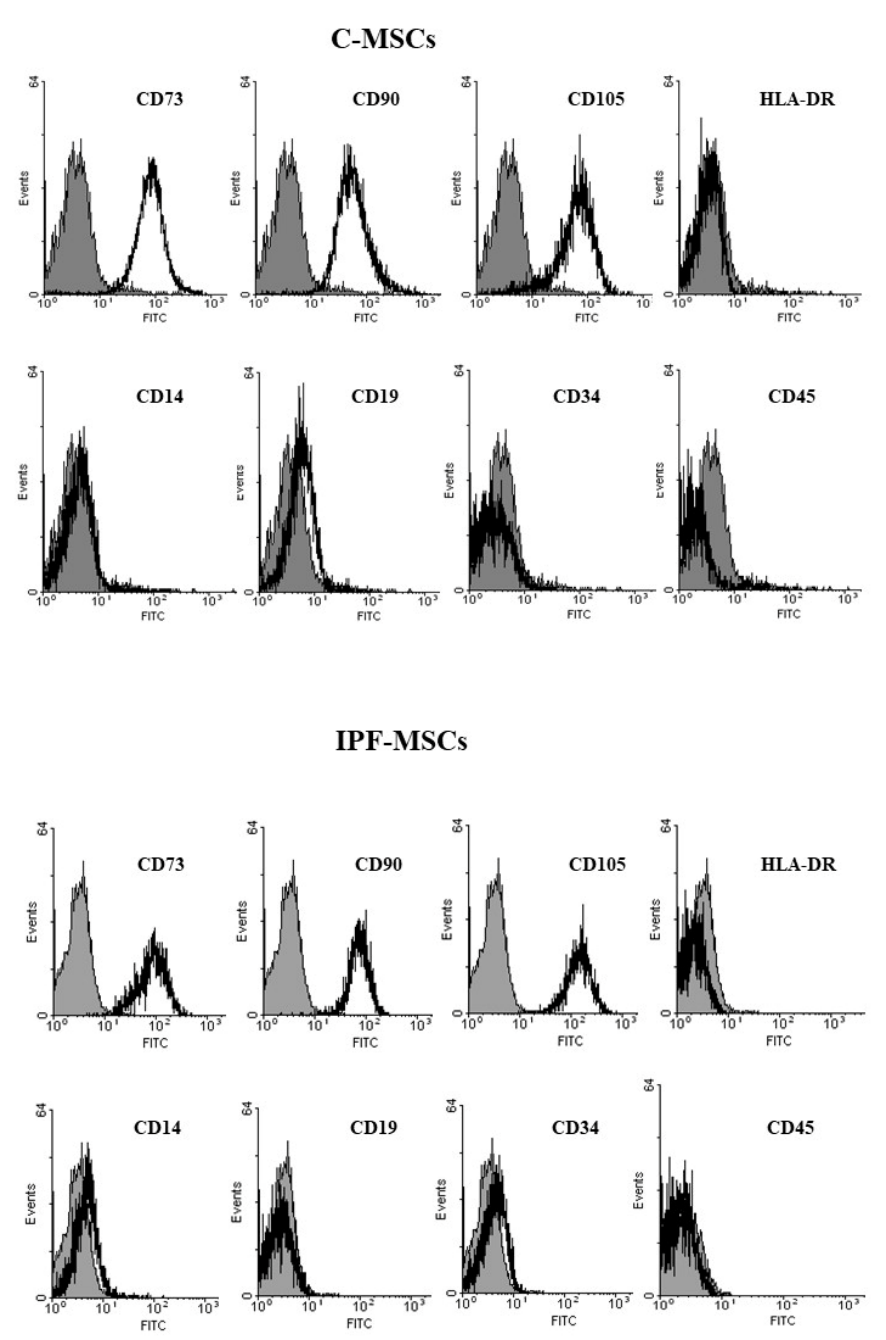
Figure 2. Immunophenotype of Mesenchymal stem Cells (MSCs). Representative FACScan analyses of cell-surface antigen expression, as indicated. Solid gray histograms refer to the negative control (IgG1 isotype control-FITC labeled). No differences were observed between MSCs isolated from the different subgroups .